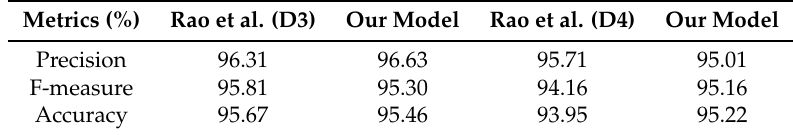
Table 10. Comparison of the proposed model with existing baseline models on D3,